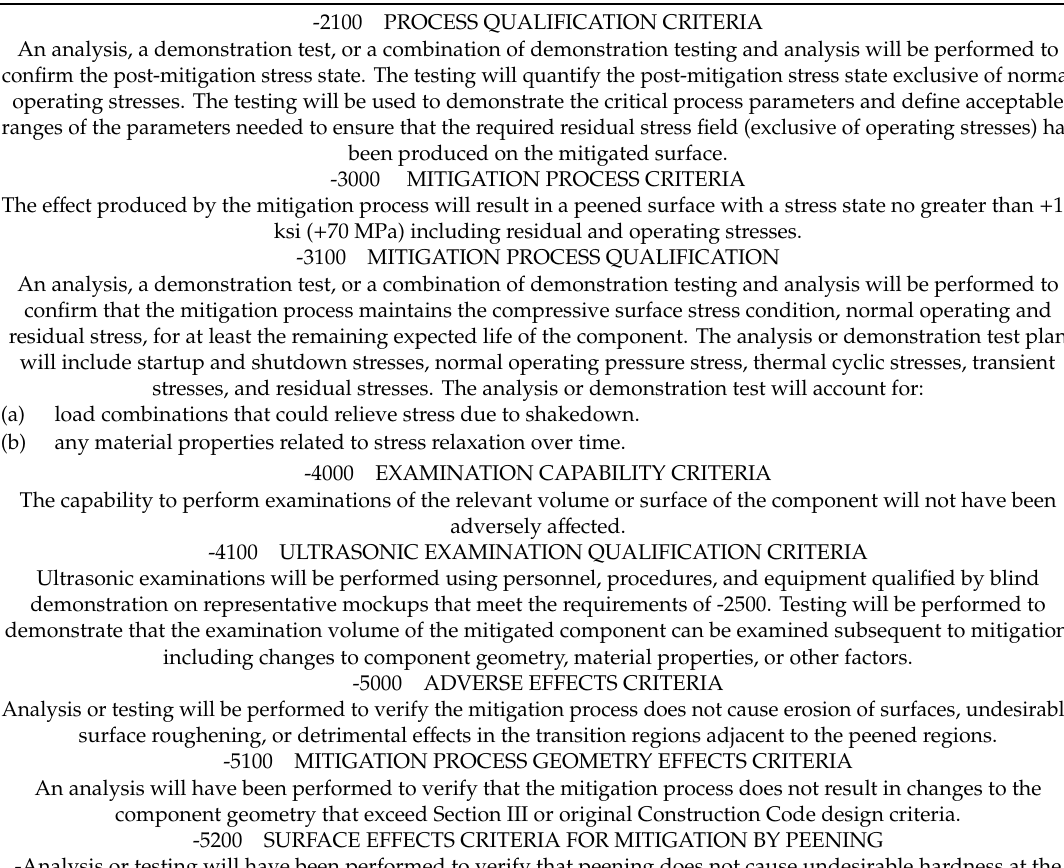
Table 7. Initial draft of the Code Case for the iterative review and consensus